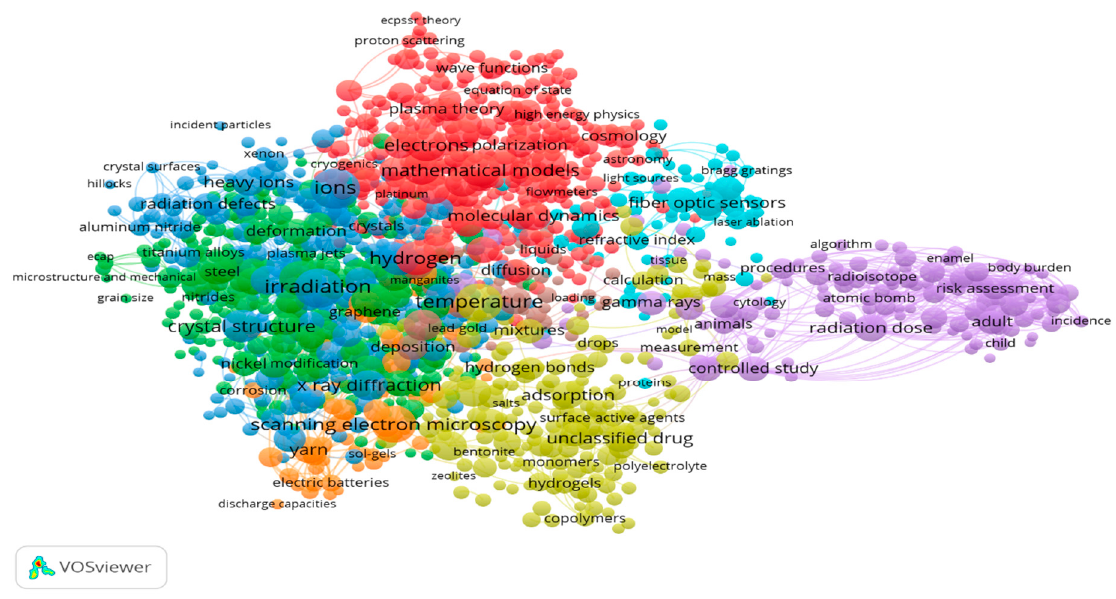
Figure 2. A keyword co-occurrence network for the subject area Physics and Astronomy.